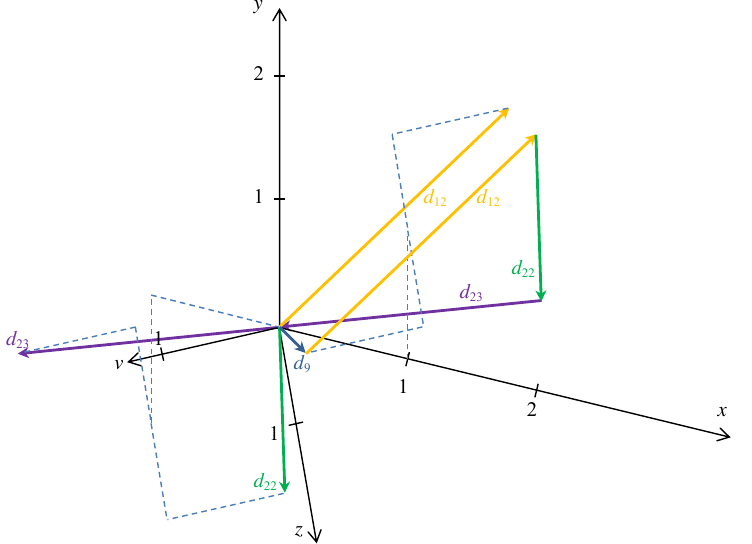
Figure 4. The sum of four diagonal vectors is the zero vector, each vector is also shown from the